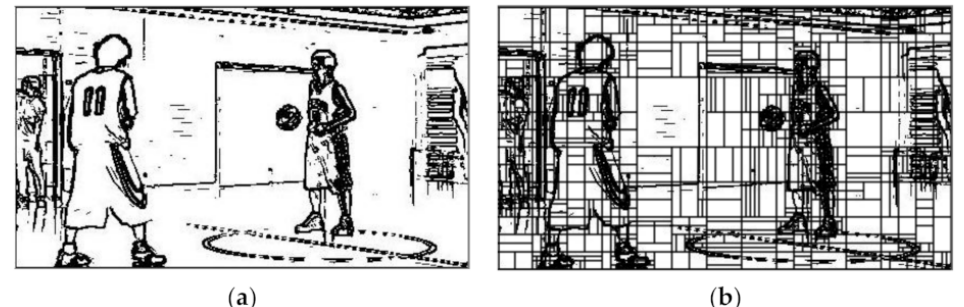
Figure 6. Edge detection result: ( a ) edge detection result of a frame in the “BasketballPass” sequence; ( b ) edge detection result with CU